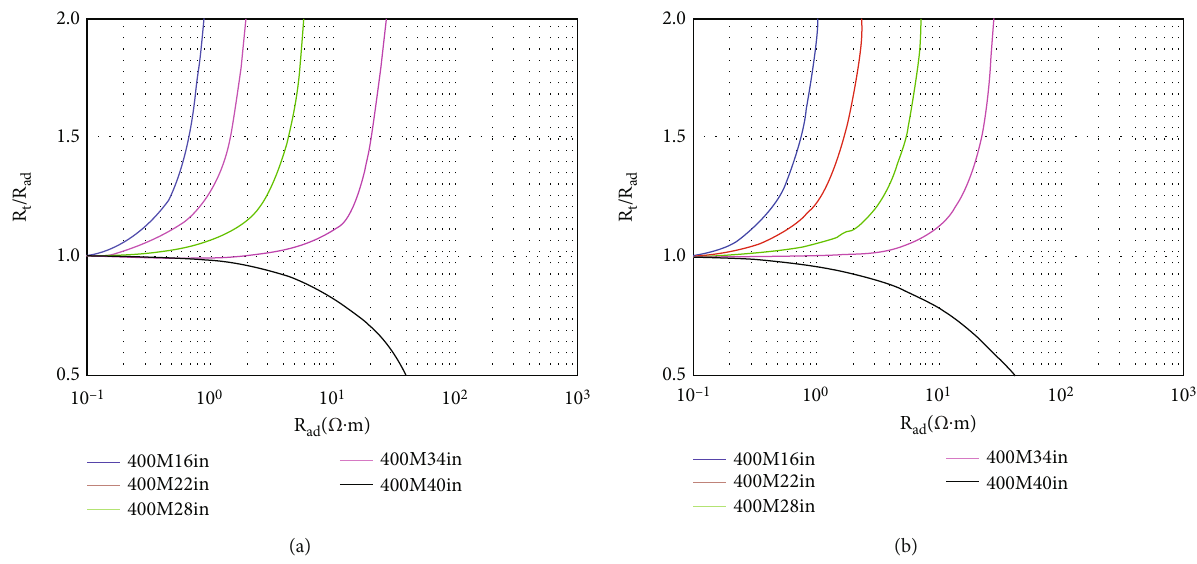
Figure 4: (a) Charts of ARC675 (400kHz, dh = 14 in , Rm = 0 : 02 Ω · m ) in the references. (b) Charts of ARC675 (400kHz, dh = 14in , Rm = 0 : 02 Ω · m ) in this paper.